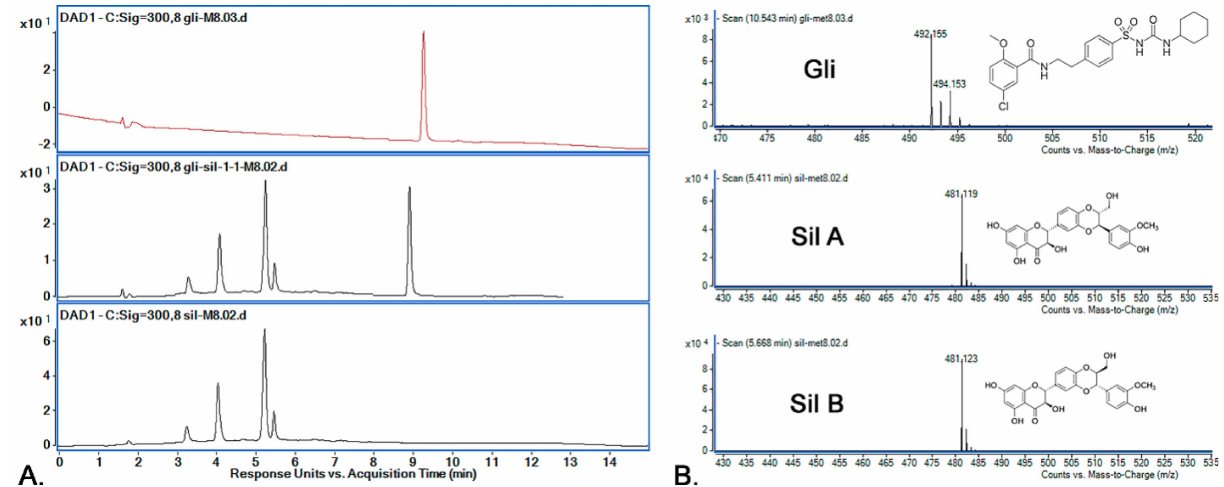
Figure 7. ( A ) Chromatograms obtained by HPLC-DAD (300 nm) for the active substances’ mixtures using M 8 ; retention times: Sil A 5.41 min, Sil B 5.66 min and Gli 10.54 min; ( B ) active substances’ (Sil A, Sil B, Gli) identification using mass spectrometry.